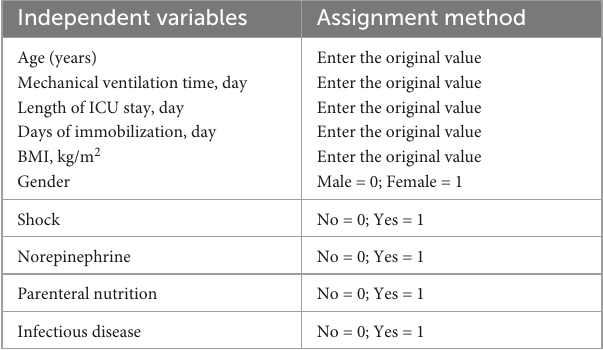
Independent variables Assignment